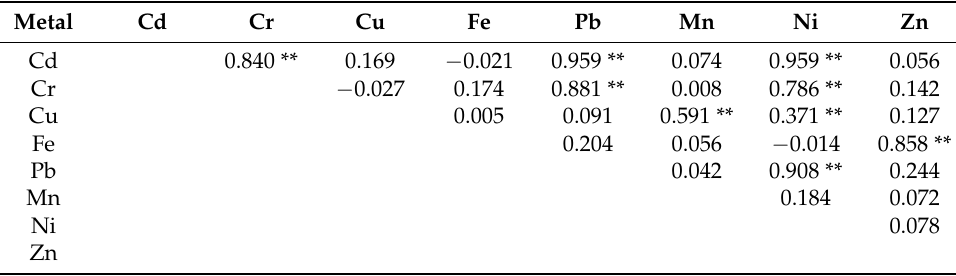
Table 11. Correlation analysis on heavy metals in groundwater samples using SPSS ( N =